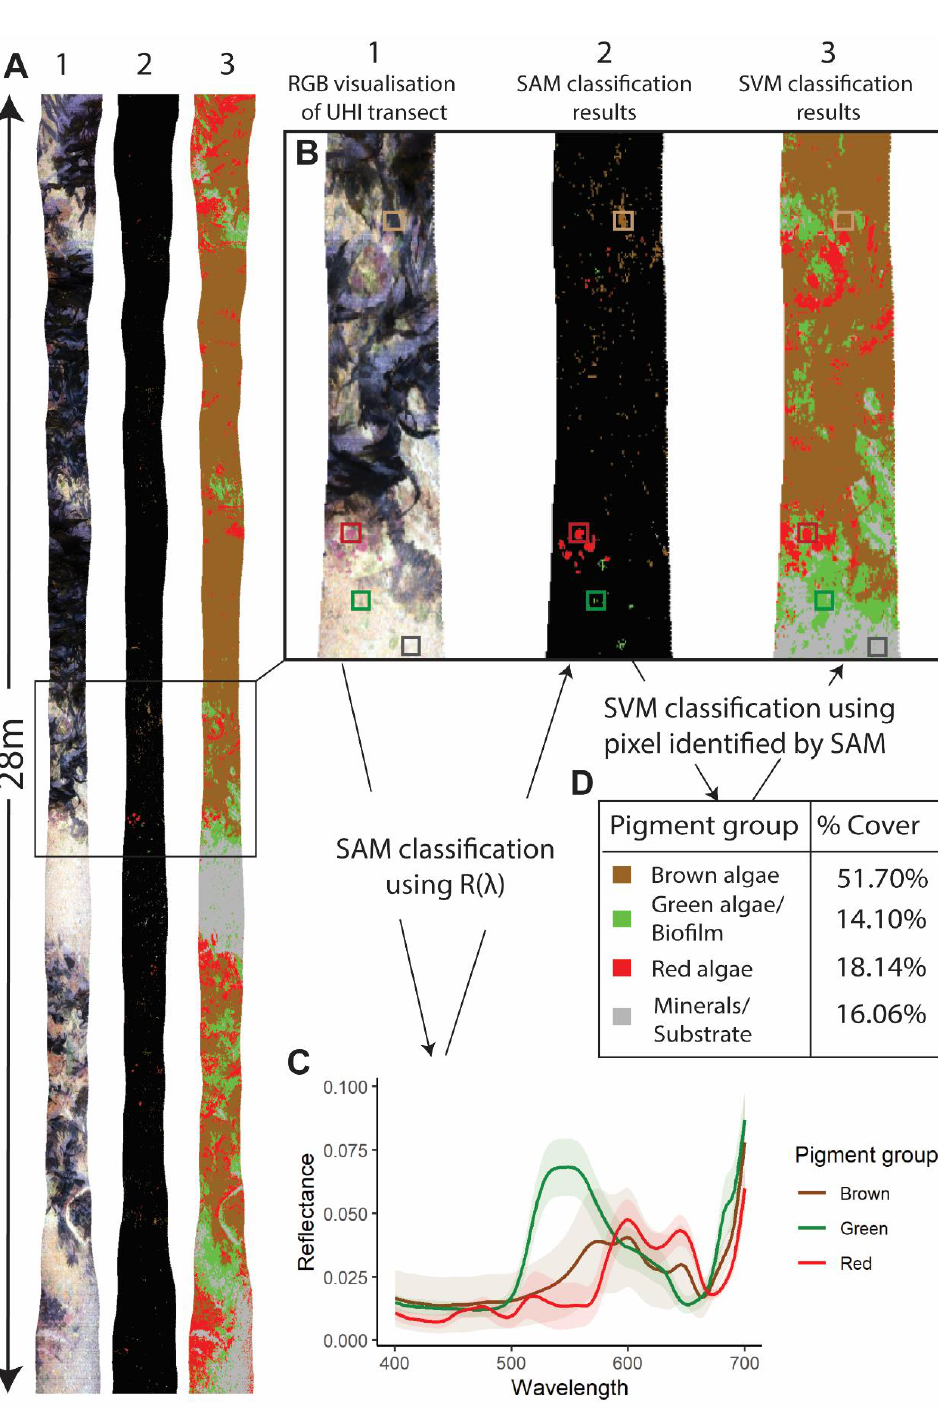
Figure 5. ( A , B ) Stages (1 – 3) for making a map of the macroalgal habitat. Stage 1, RGB visualisation of the UHI transect; Stage 2, Application of spectral angle mapper (SAM) algorithm based on the spectral library of brown, red and green macroalgal in vivo reflectance spectra taken in the lab ( C ); Stage 3, Support Vector Machine (SVM) classification of all remaining pixel into green, brown, red macroalgae and substrate using from SAM pixels as training data. ( C ) In vivo reflectance spectra (R(λ)) with standard error of the mean for each pigment group, measured with a spectrometer. Low R( λ ) indicates high absorption at 650 nm (chl b) and 677 nm for green algae, 530–570 nm (phycoerythrin) and 680 nm (chl a) for red algae and lastly 535 nm (fucoxanthin), 630 nm (chl c) and 674 nm (chl a) for brown algae. ( D ) Percent areal cover of each